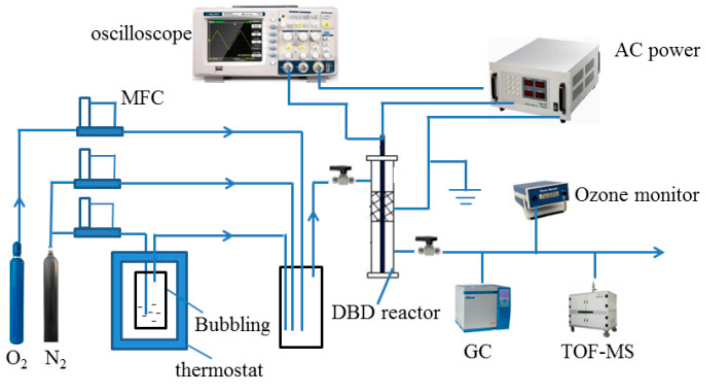
Figure 1. The schematic diagram of the experimental device.